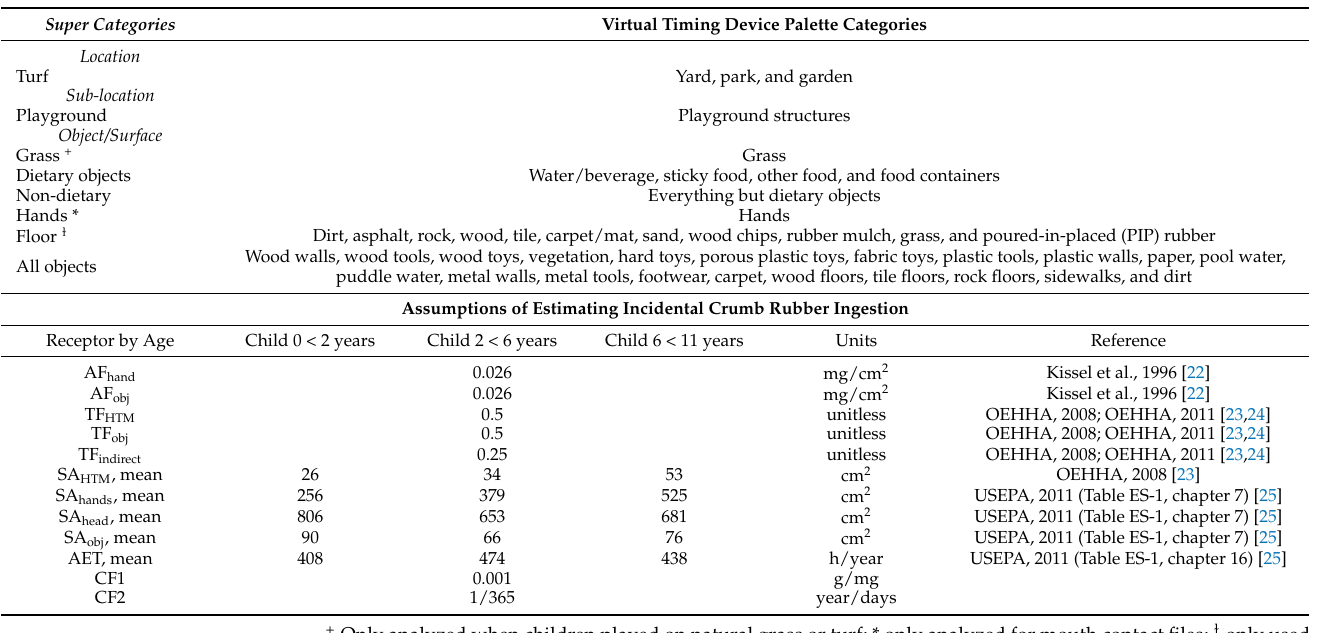
Table 1. Selected categories for objects/surfaces on turf and playgrounds and assumptions of estimated incidental